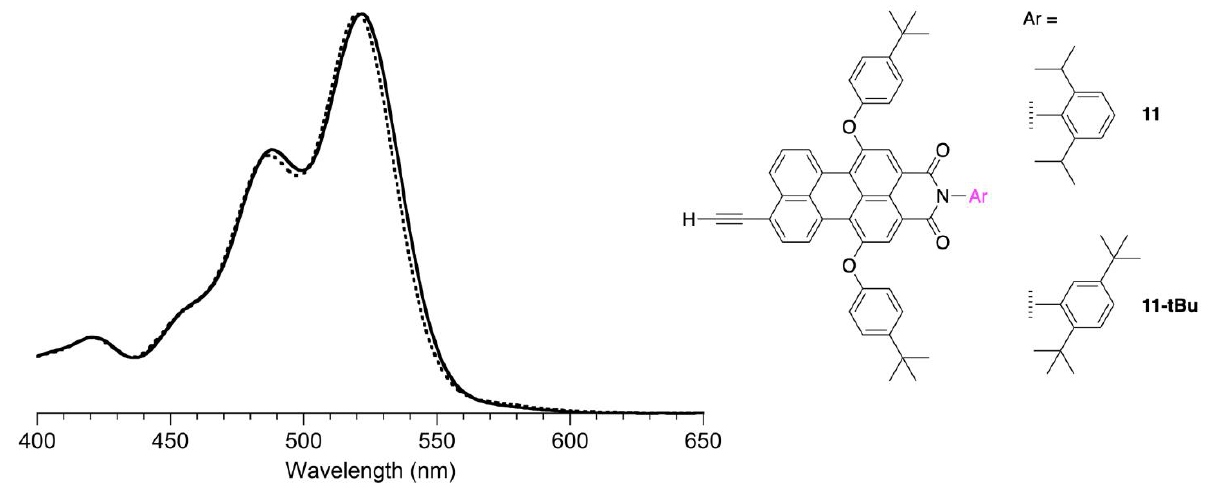
Figure 3. Absorption spectra (solid lines) in toluene at room temperature of ethynyl-perylene 11 ( λ abs 522 nm, ε 522 nm = 40,500 M − 1 cm − 1 , solid line) and ethynyl-perylene 11-tBu ( λ abs 520 nm, dashed line).